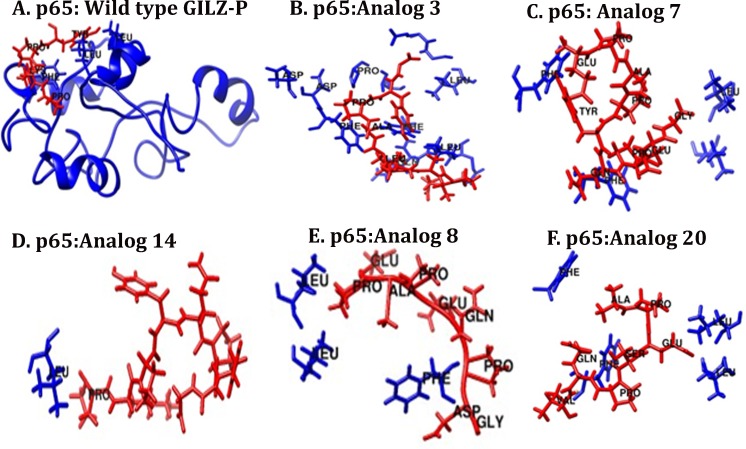
The docked complex of wild type GILZ-PER (proline glutamic acid rich region) or GILZ analog (GA) with human p65-TAD.Representative molecular model of p65-TAD docked (blue) with wild type GILZ-PER (A) and indicated analog (B-F) (red) are shown. The residues in each analog <5Å distance of highly conserved residues in p65-TAD2 (Phe or Phe) and the “LXXLL” motif in p65-TAD1 that suggest proximity with residues critical for transcriptional activity are shown.